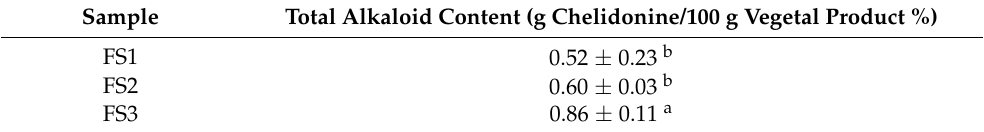
Table 1. The total alkaloid content of the tested F. schleicheri samples.